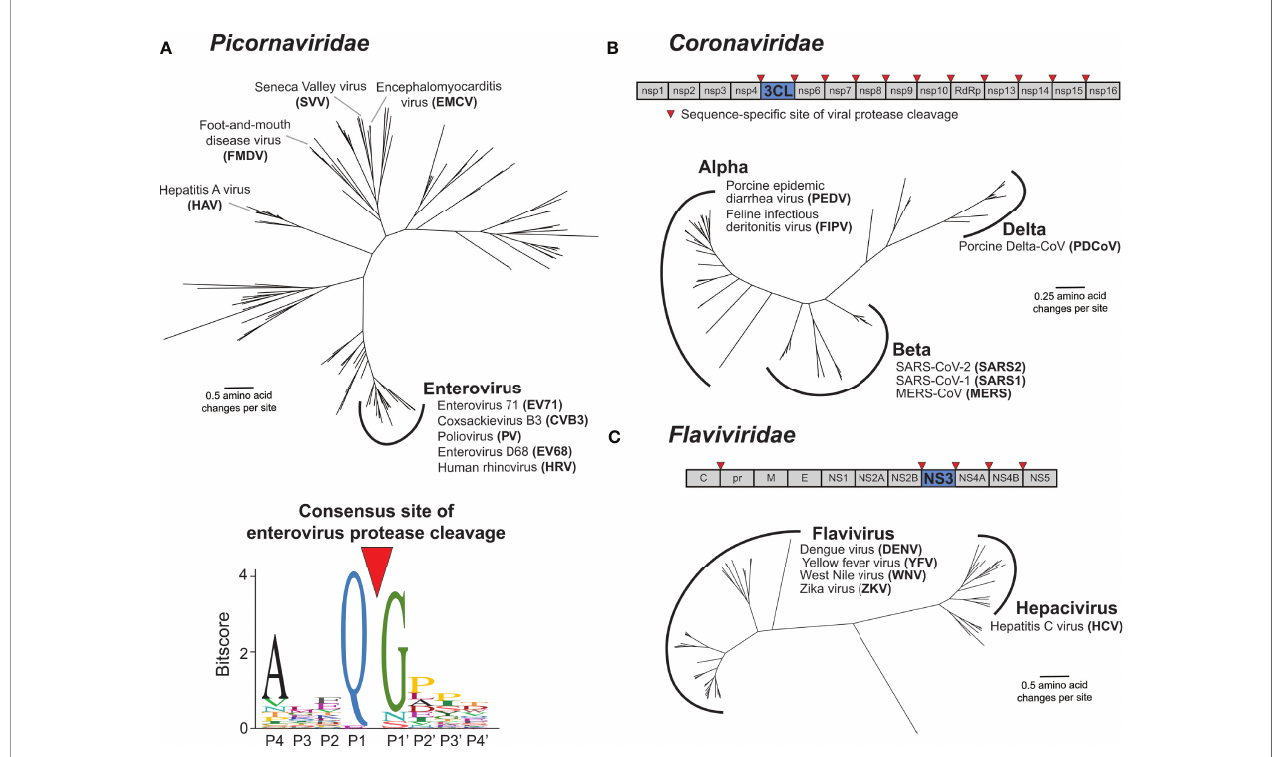
FIGURE 3 | Main proteases in Picornaviridae, Coronaviridae , and Flaviviridae . (A) Phylogenetic tree of available RefSeq Picornaviridae 3C protease protein sequences (151 total, top). Names of viruses with human relevance or referenced throughout the text are listed next to their respective genus or singular node. The consensus enterovirus 3C cleavage motif (bottom) as was generated previously (15). The cleavage site is shown fl anked by four amino acids upstream (labeled P4 through P1) and four amino acids downstream (labeled P1 ’ through P4 ’ ). (B) Schematic of the SARS-CoV-2 (family: Coronaviridae ) nonstructural (ORF1ab) polyprotein, with the position of the 3CL protease and sites of 3CL-mediated cleavage shown. Phylogenetic tree of available RefSeq Coronaviridae 3CL protease protein sequences (64 total). Names of viruses with human relevance or referenced throughout the text are listed next to their respective genus. (C) Schematic of the dengue virus (DENV) (family: Flaviviridae ) polyprotein, with the position of the NS3 protease and sites of NS3-mediated cleavage shown. Phylogenetic tree of available RefSeq Flaviviridae NS3 protease protein sequences (68 total). Names of viruses with human relevance or referenced throughout the text are listed next to their respective